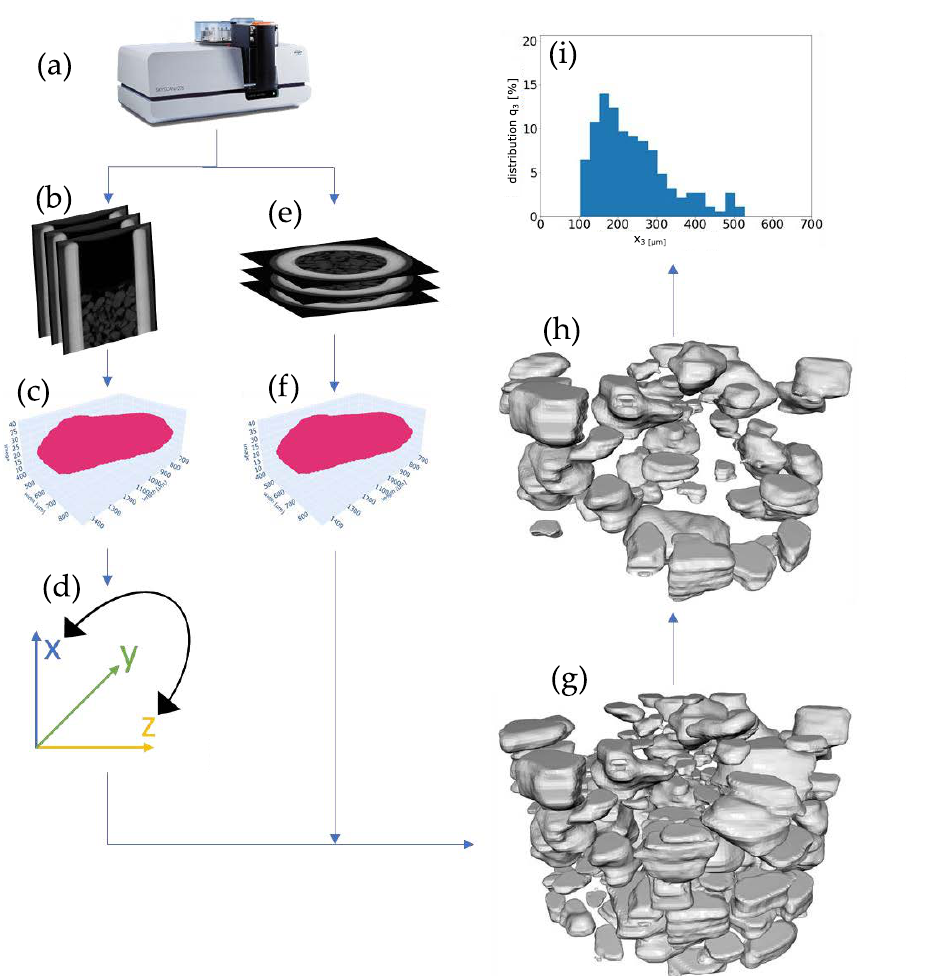
Figure 3. Workflow of the measurement procedure and post-processing. Samples were given to the sampler and scanned in the µCT ( a ). Scans were reconstructed into radial and axial 2d images ( b , e ). From the scans, the artificial intelligence was applied and point clouds in both directions were created ( c , f ), After transformation ( d ), the point clouds were reconstructed into a three dimen- sional representation (meshe) ( g ). After falsely identified particles were sorted out ( h ) the PSD was determined ( i